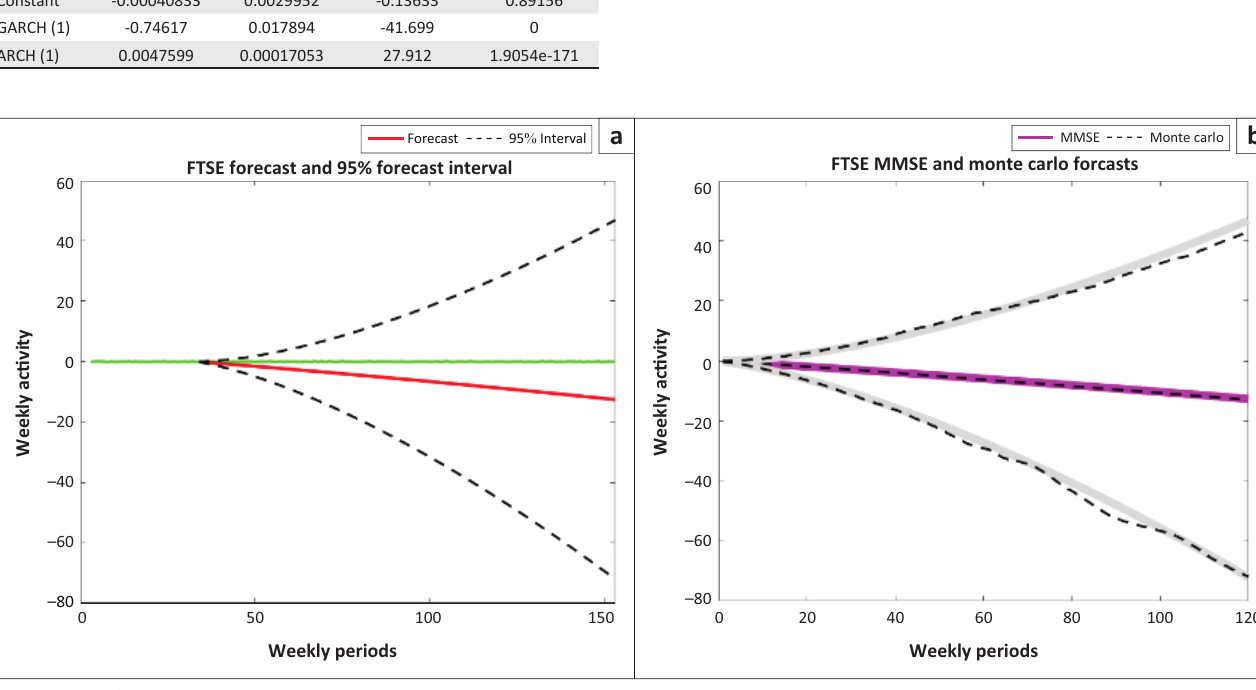
MMSE, Monte Carlo and a minimum mean square